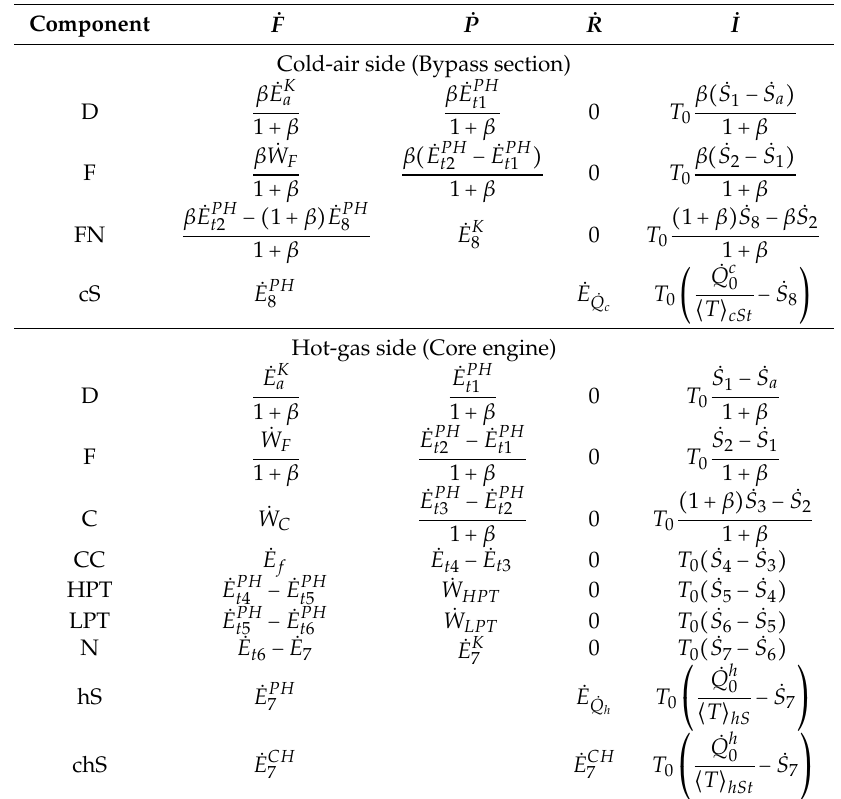
Table 3. Resources, products, residues, and irreversibilities of the turbofan